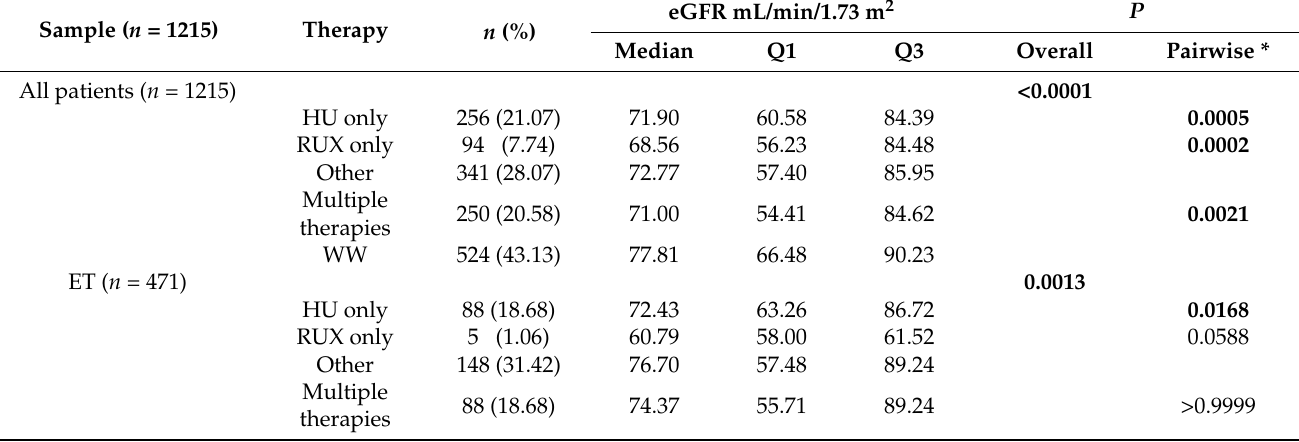
Table 5. Median eGFR in patients treated with HU, RUX, or